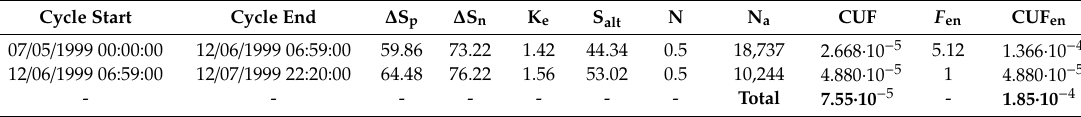
e : elastic-plastic